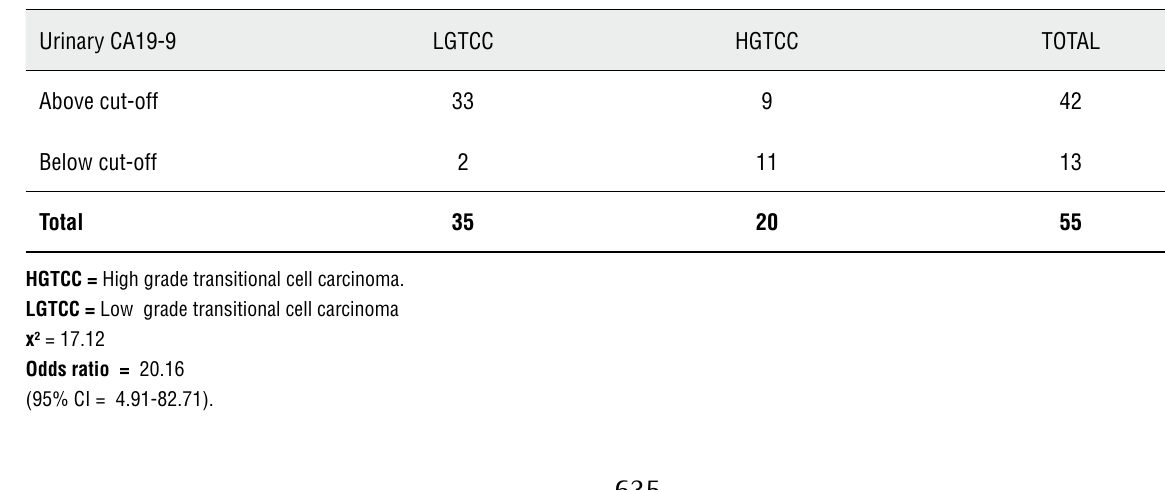
1 - Diagonal segments are produced by ties